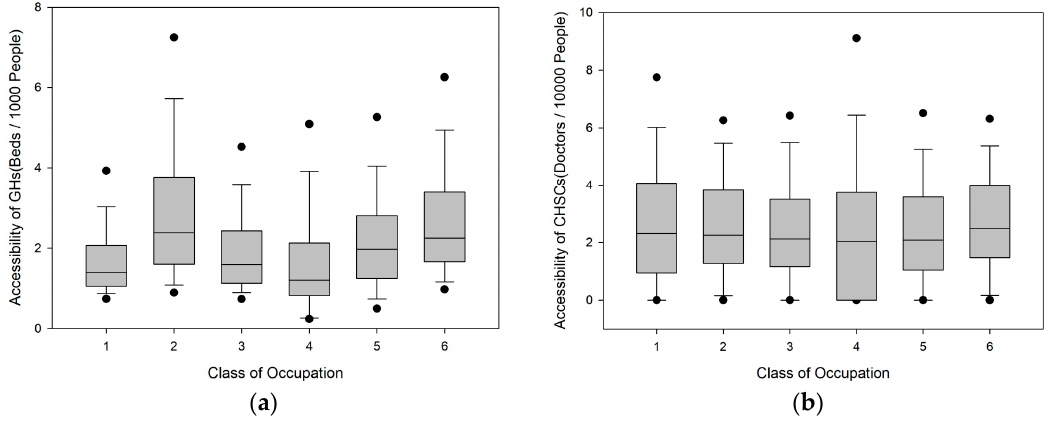
Figure 7. Box-plots of the accessibility for di ff erent classes of occupation. ( a ) Box-plots of the accessibility of GHs; ( b ) Box-plots of the accessibility of CHSCs.